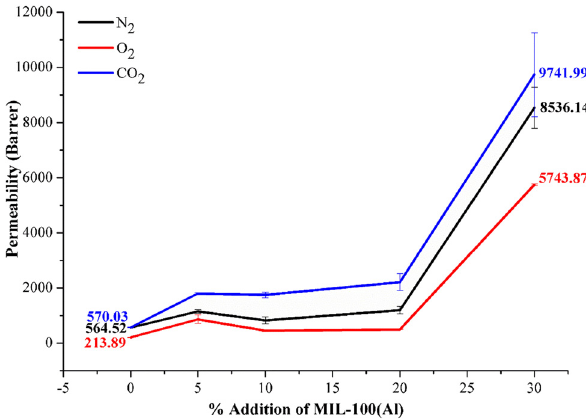
Figure 13: Gas permeability graph of CO 2 , O 2 , and N 2 for di ff erent percentage additions of MIL - 100 ( Al ) to PES.